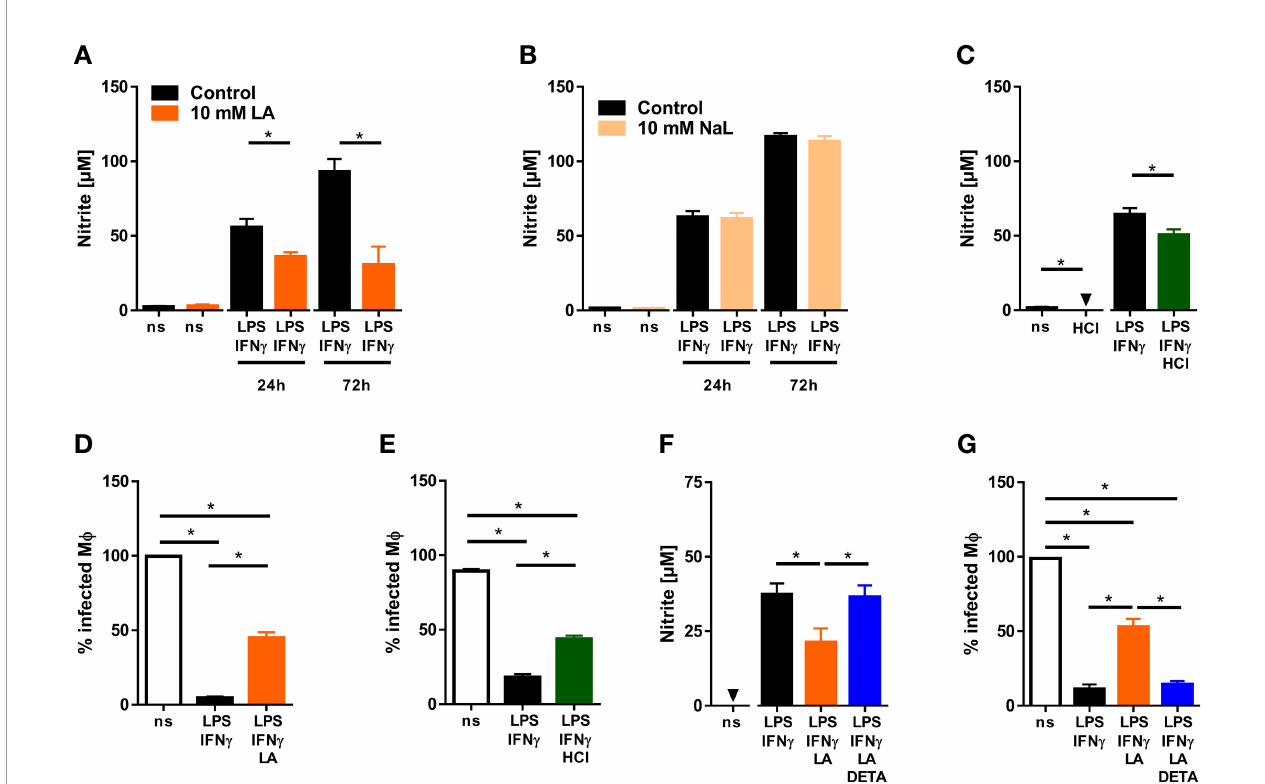
FIGURE 2 | Low pH reduces NO production and impairs anti-leishmanial defenses of LPS/IFN- g -coactivated macrophages. (A, B) BMDM were stimulated with LPS (10 ng/ mL)/IFN- g (20 ng/mL) or left unstimulated (ns) for 24 - 72 h. Where indicated, 10 mM lactic acid (LA) or 10 mM sodium lactate (NaL) were added. (A) Nitrite levels were determined at indicated time points (means + SEM, n = 10-29 samples from at least four independent experiments; * p < 0.01, Student ’ s t-test + Welch correction or Mann- Whitney test). (B) Nitrite levels were determined at indicated time points (mean + SEM, n = 16-40 samples from ten independent experiments; * p < 0.01, Mann-Whitney test). (C) As in (A) , but cells were stimulated with 10 mM HCl for 24 h (means + SEM; n = 12-16 from at least two independent experiments; * p < 0.05, Student ’ s t-test or Mann- Whitney test). (D – G) BMDM were infected with L. major and costimulated with LPS (20ng/mL)/IFN- g (20 ng/mL) or left unstimulated (ns) for 72 h. Where indicated cells were additionally exposed to 10 mM HCl or 10 mM LA and/or 25 µM DETA-NO (DETA). (D) Infection rate (mean + SEM, n = 29-30 high power fi elds from three independent experiments; * p < 0.05, Kruskal-Wallis test and Dunn post hoc test). (E) Infection rate (mean + SEM, n = 16 high power fi elds from two independent experiments; * p < 0.05, ANOVA with Bonferroni ’ s test). (F) Nitrite content of supernatants (mean + SEM, n = 14 from three independent experiments; * p < 0.05, Kruskal-Wallis test and Dunn post hoc test. (G) Infection rate (mean + SEM, n = 18 high power fi elds from three independent experiments; * p < 0.05, Kruskal-Wallis test and Dunn post hoc test).